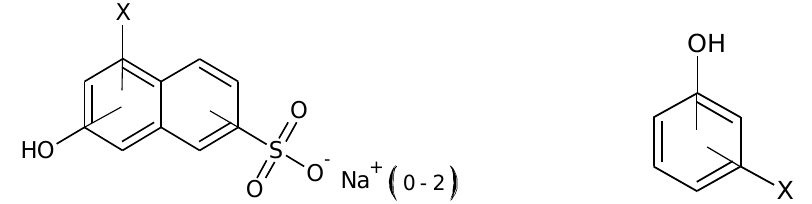
Figure 5. Detected by-products formed during ozonation in alkaline reaction medium (based on thin layer chromatography (TLC)).